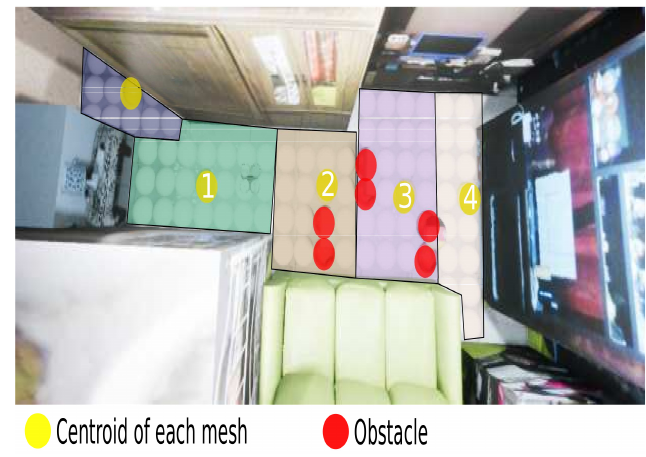
Figure 7. Visual representation of navigation meshes.